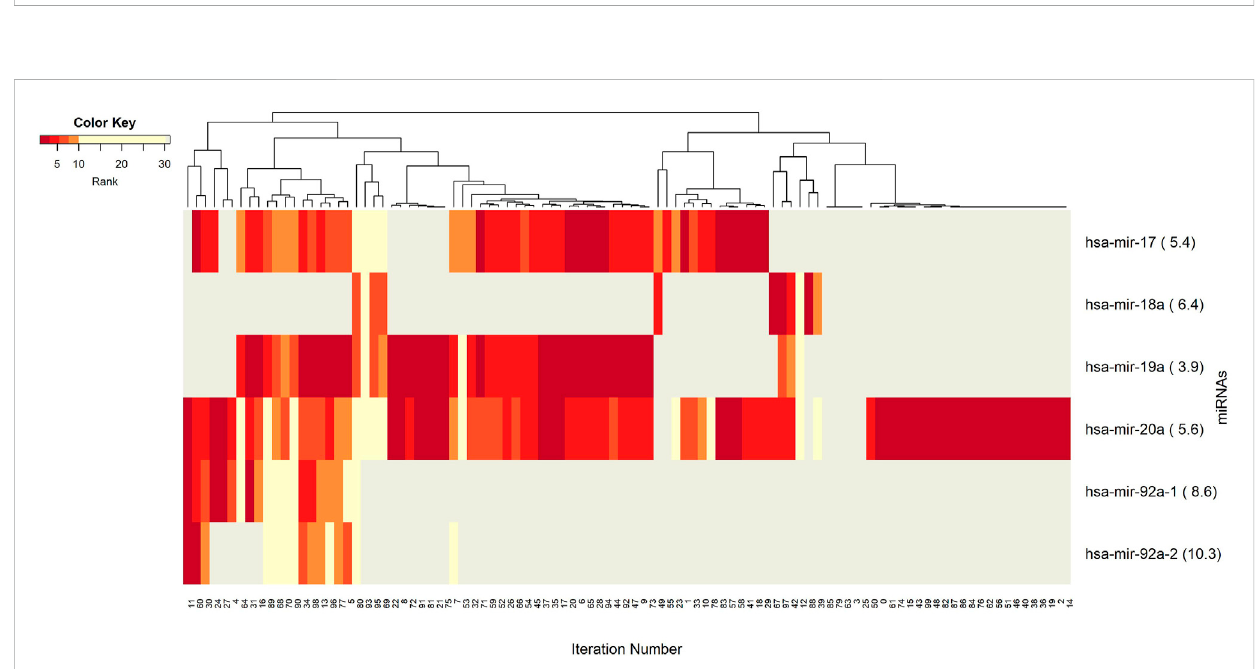
FIGURE 4 Heatmap ofmiRNAfeatureswith rank information for eachsplit. Co-occurrencesover thesplits ofthegroupcomponentmiRNAsare revealed. The color key encodes the rank of each miRNA, where dark red indicates the top ranking. Gray displays non-detected miRNAs for the corresponding